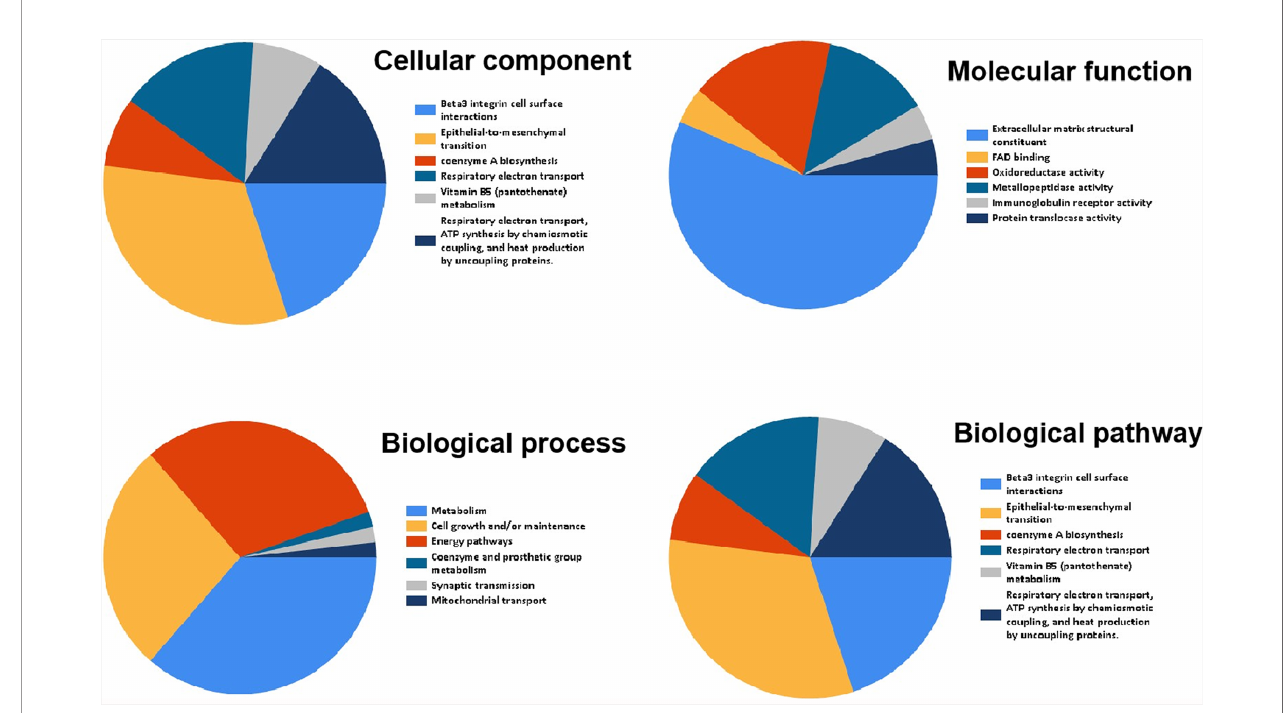
FIGURE 7 | Go and KEGG pathway enrichment analysis of overlapped differentially genes.